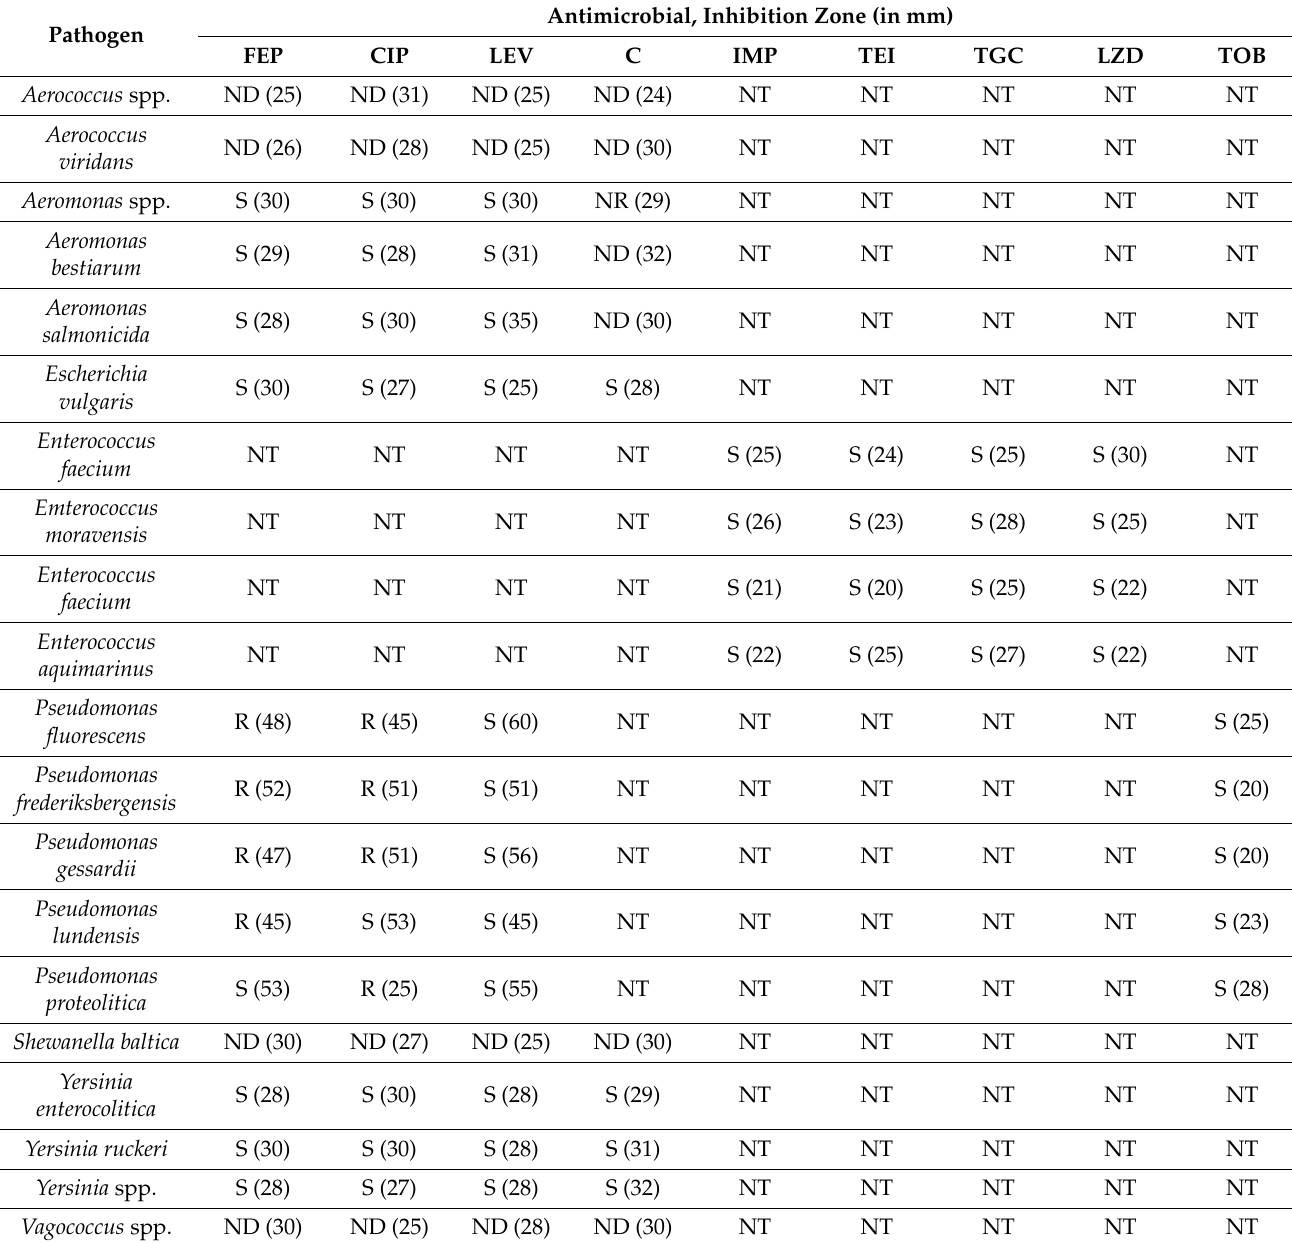
Table 2. Antimicrobial resistance of fish